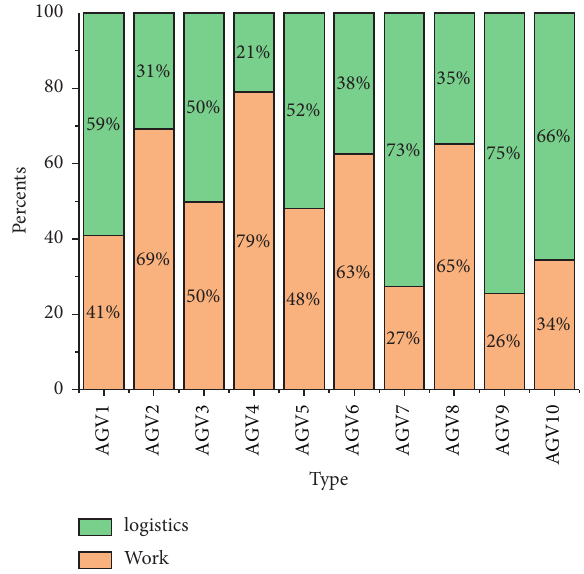
Figure 2: Work hours at each station of the digital twin